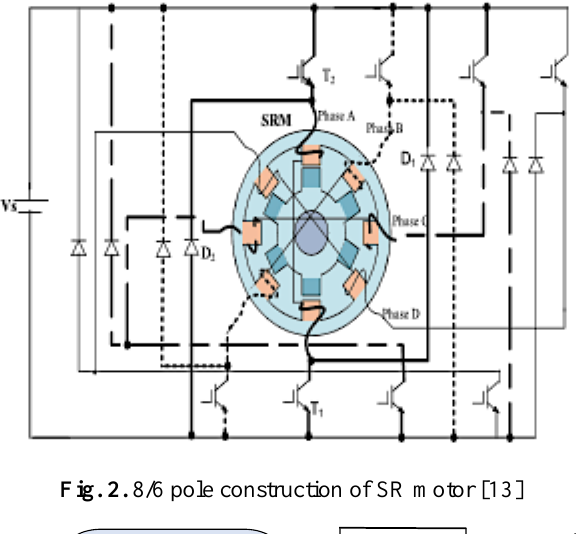
Fig. 2. 8/6 pole construction of SR motor [13]